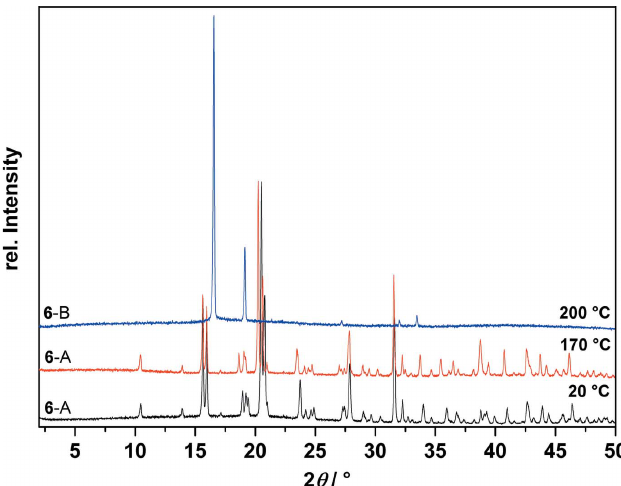
Figure 14 Overlay of the crystal structures of 5 -D (red, Pbca , Z 0 = 1) and 5 -E (blue, P 2 1 2 1 2 1 , Z 0 = 2). View approximately along the c axis ( a axis shown in red, b axis shown in green, c axis shown in blue), H atoms have been omitted for clarity.